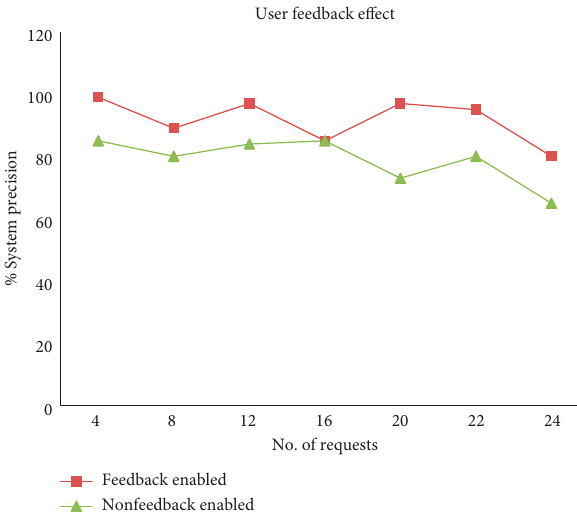
Figure 7: Mechanism selection